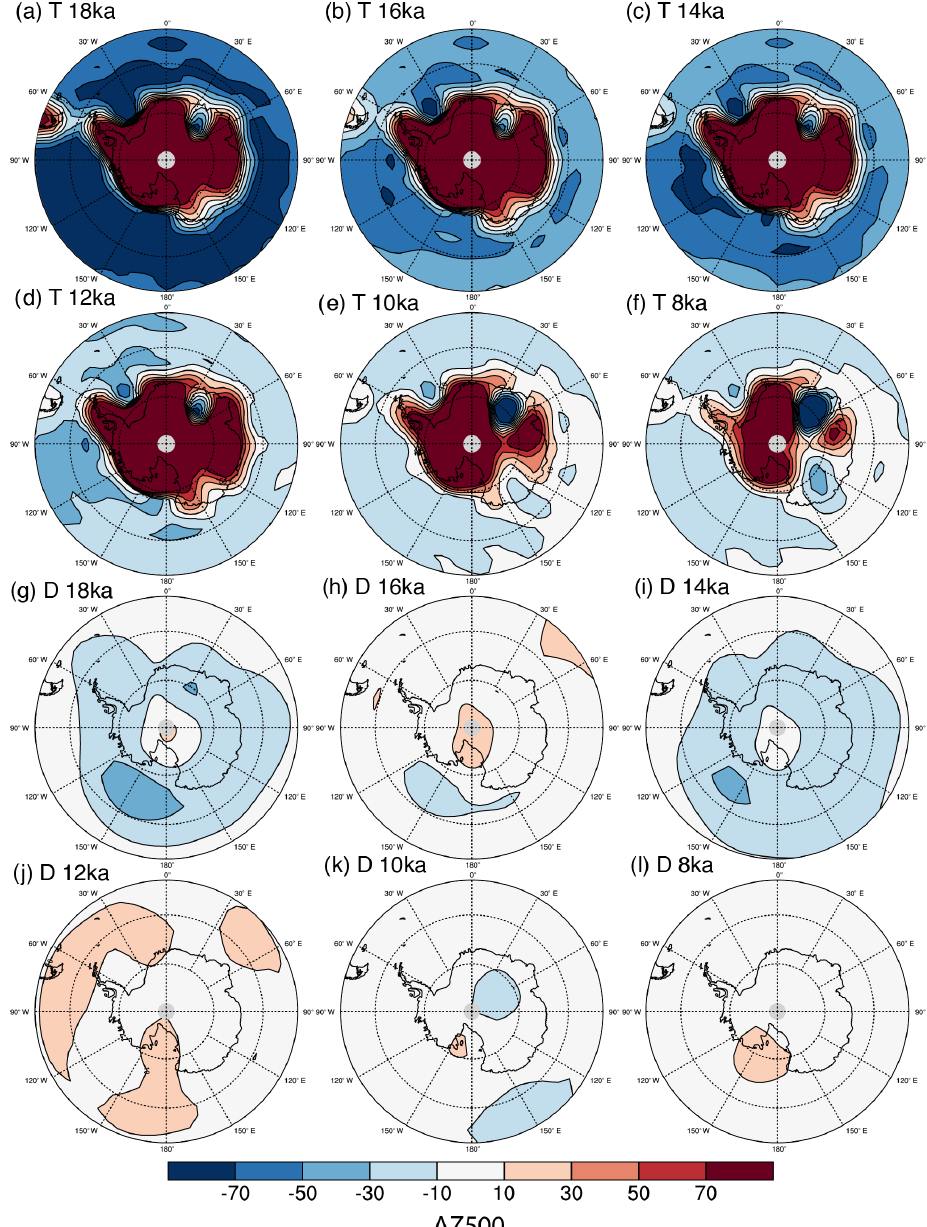
Figure 14. Geopotential height anomalies (unit: metres) at 500hPa relative to PI for the (a–f) TraCE-21ka and (g–l) DG ns deglacial experi- ments (maximum latitude of 50 ◦ S). Dotted lines indicate latitude (intervals of 15 ◦ ) and longitude (intervals of 30 ◦